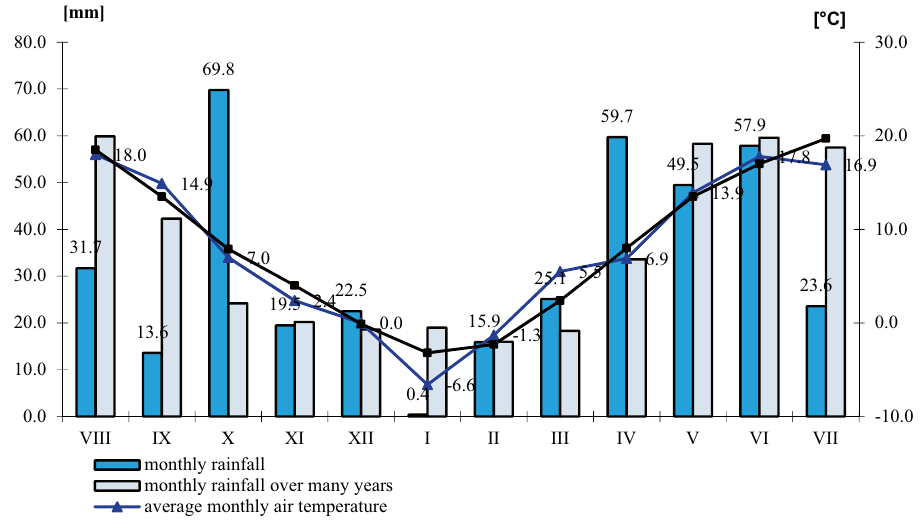
Figure 2. Monthly rainfall totals and average air temperature during the growing season 2016–2017 in RSD Zawady of many years of many years (1996–2010).